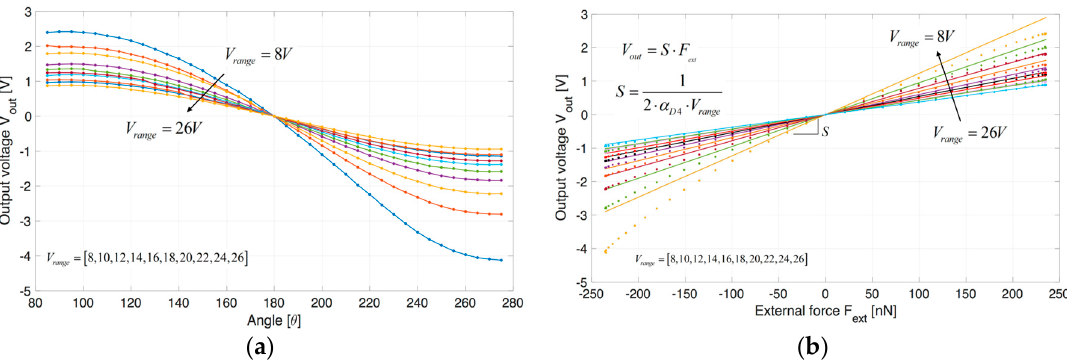
Figure 3. ( a ) Measured output voltage (cid:1848) (cid:2925)(cid:2931)(cid:2930) as a function of the angle θ of the rotating stage for different values of (cid:1848) (cid:2928)(cid:2911)(cid:2924)(cid:2917)(cid:2915) ; ( b ) Measured output voltage (cid:1848) (cid:2925)(cid:2931)(cid:2930) as a function of the external weight force for different values of (cid:1848) (cid:2928)(cid:2911)(cid:2924)(cid:2917)(cid:2915) . Raw data are represented with dots while lines represent a fitting with a polynomial of 1st